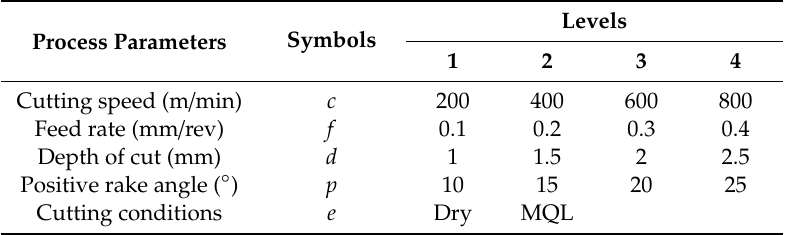
Figure 2. Schematic of a coordinate measuring machine.